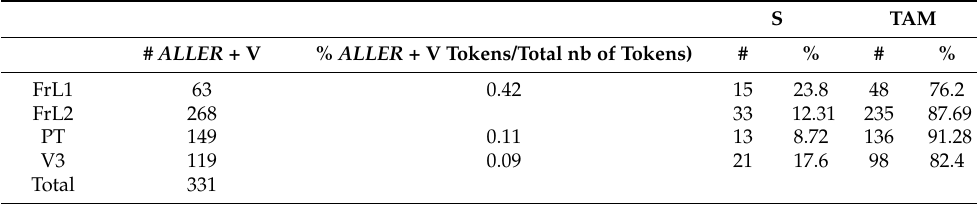
Table 5. Number and percentage of occurrences in interview data.